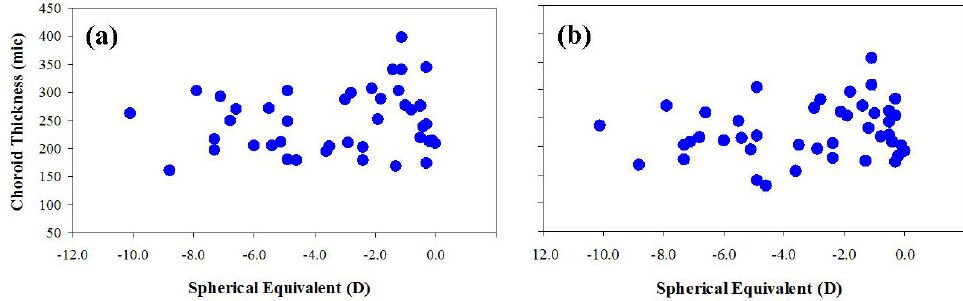
Figure 7. Choroidal thickness versus refraction for locations T1 ( a ) and T2 ( b ). No significant differences were found for both sets of data.